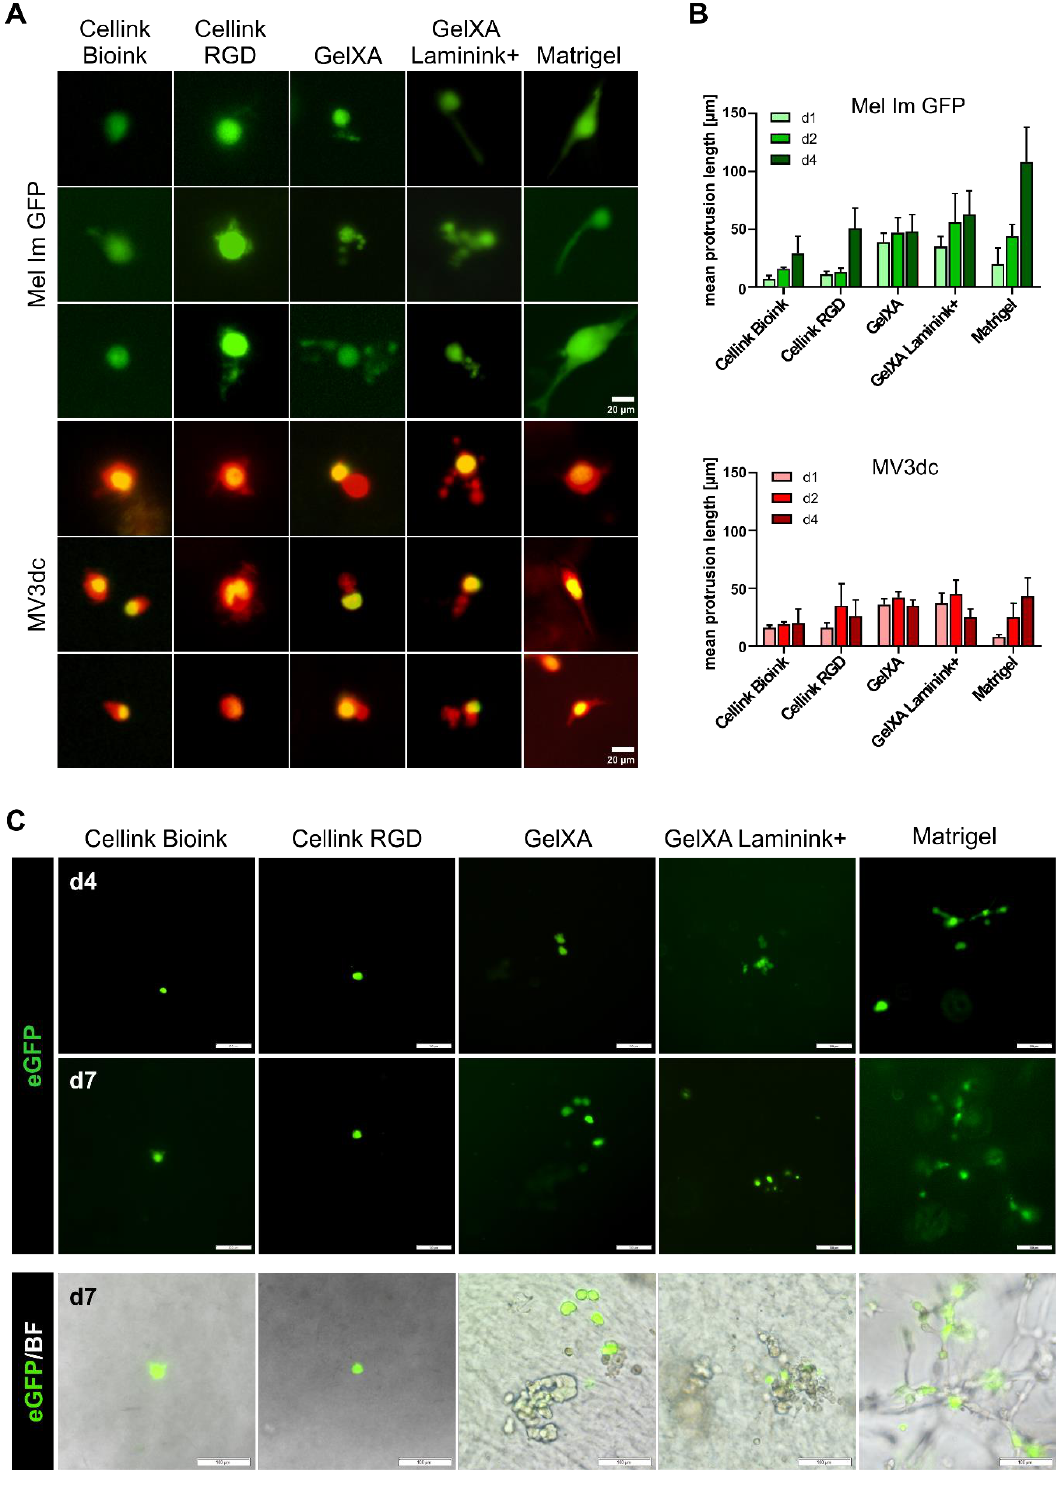
Figure 3. Morphology of melanoma cells in the different bioinks. ( A ) Fluorescence microscope images revealing the morphology of each three representative Mel Im GFP or MV3dc single cells on day 4, cultured in the different 3D matrices. The scale bars represent 20 µm. ( B ) Quantification of protrusion lengths (in 2D) of single cells at time points d1, d2, and d4 in all bioinks. Mel Im GFP spread and revealed increasing protrusion lengths over the observation period. Most distinct protrusions were observed in Matrigel. MV3dc cells revealed a tendency to form shorter protrusions in all bioinks,